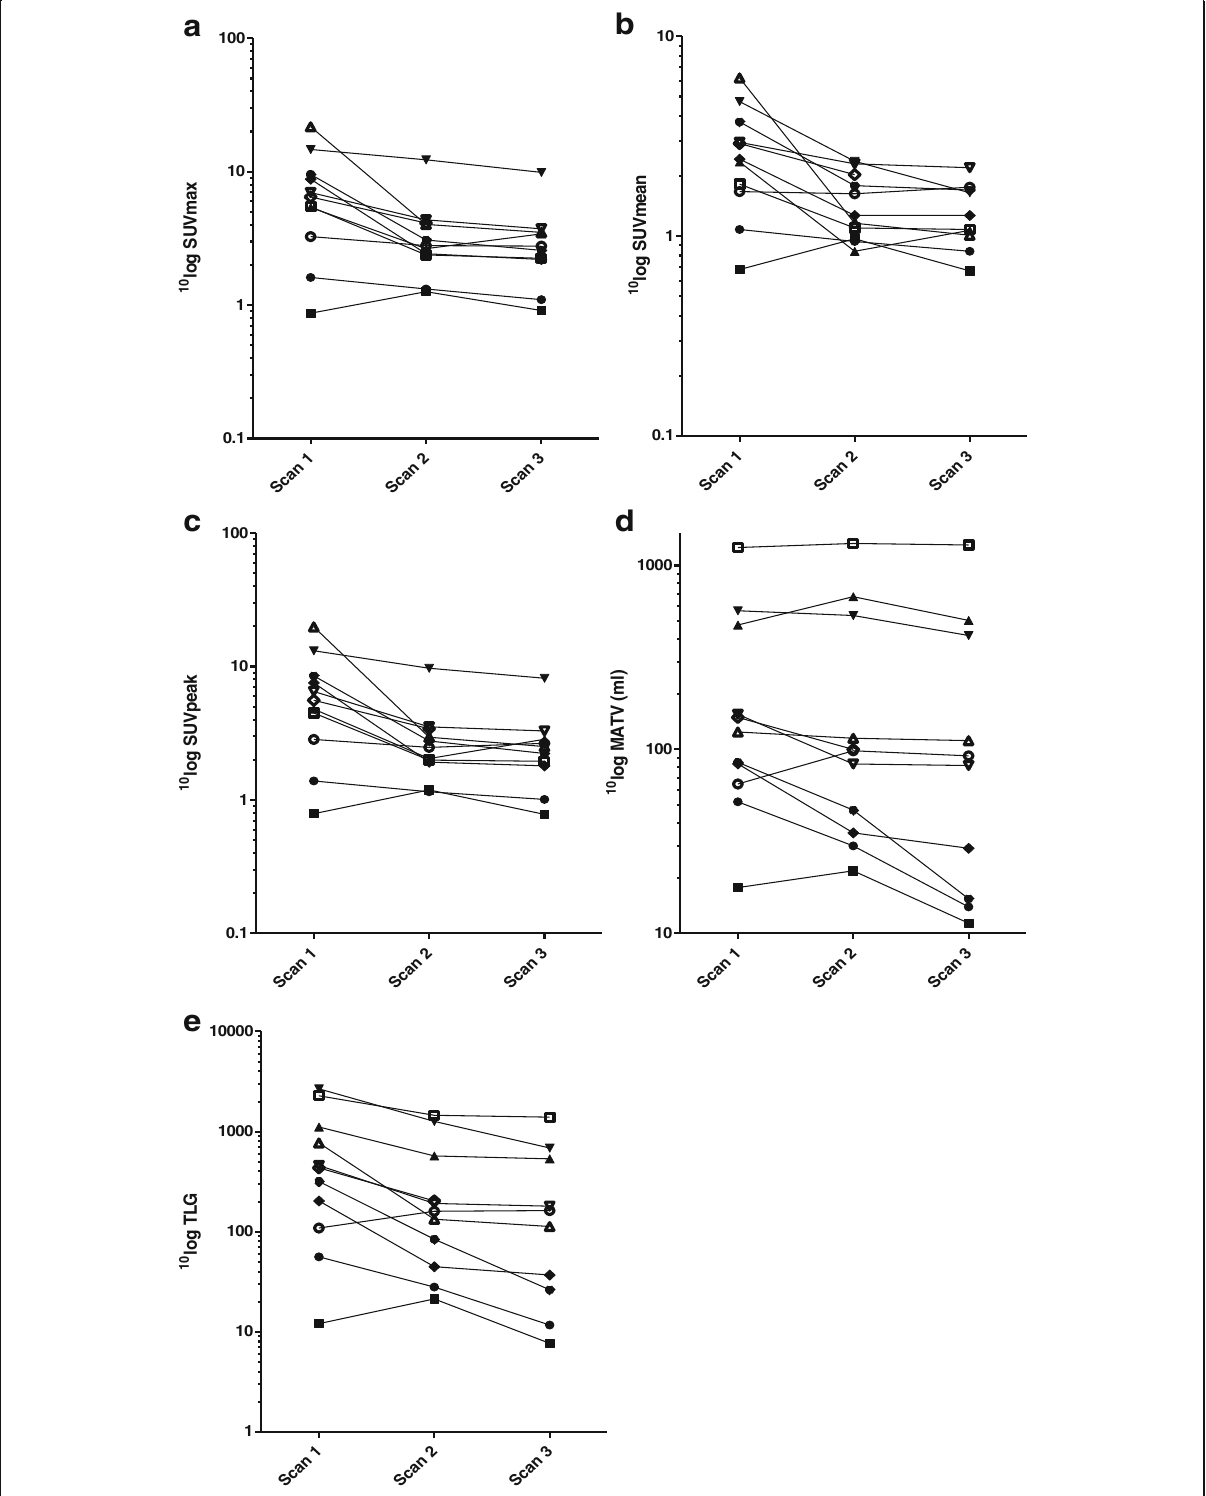
Fig. 3 Course in metabolic tumor activity (VOI man ) during neoadjuvant treatment for each patient individually. The course in metabolic tumor activity for the VOI man during the neoadjuvant treatment for each patient individually for the serial 18 F-FDG PET-CT scans. a SUV max . b SUV mean . c SUV peak . d Metabolically active tumor-volume (MATV). e Total lesion glycolysis